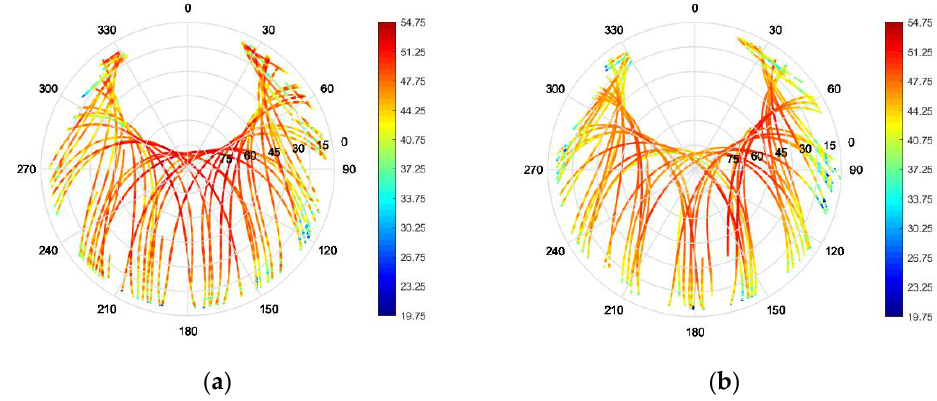
Figure 14. GNSS field measurements of the antenna array. Sky plot of C/N0 in dB of received GNSS signals at L5/E5a band over a 24-h time window. ( a ) Antenna array standalone; ( b ) Antenna array mounted on